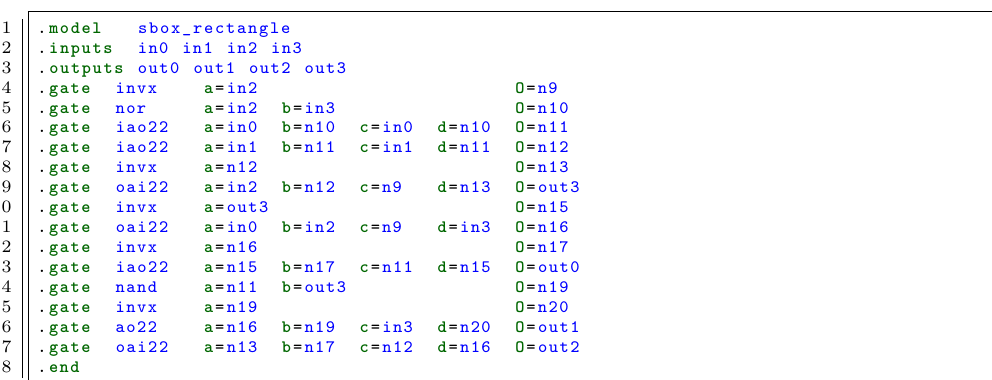
Figure 19: Combination of LIGHTER and ABC: Area-optimized hardware implementation of Rectangle Sbox using 19.00 GE with the standard cell library of the TSMC 65nm logic process.